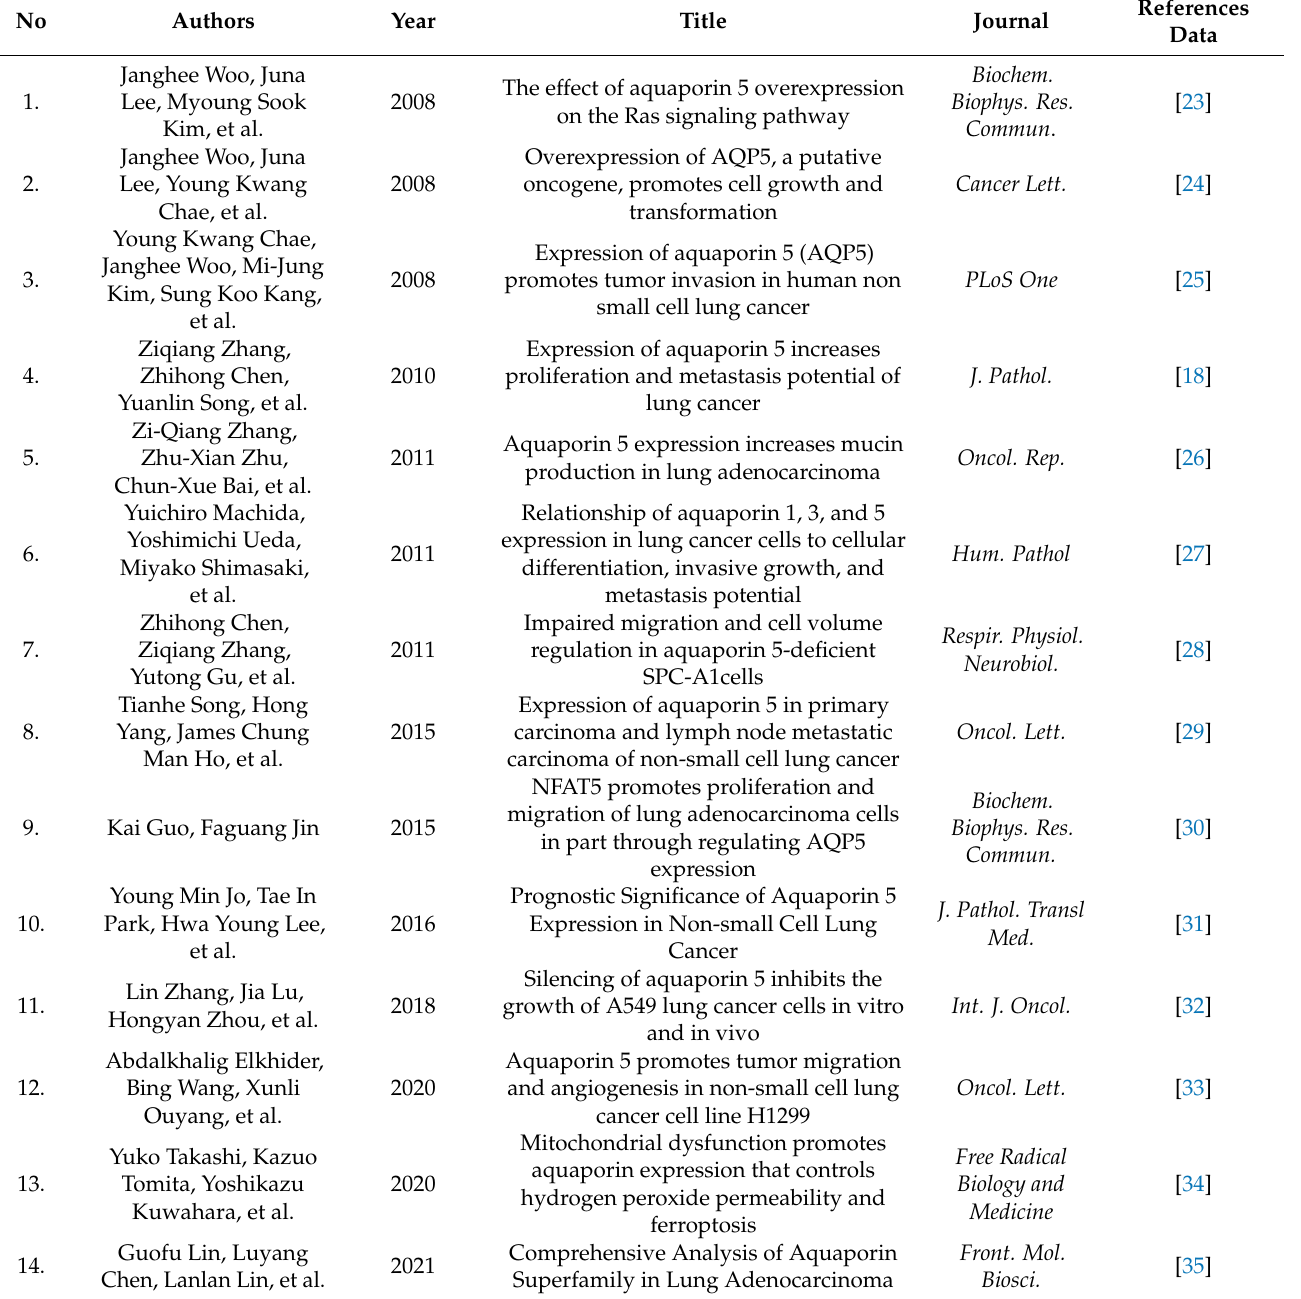
Table 1. List of papers selected for the systematic